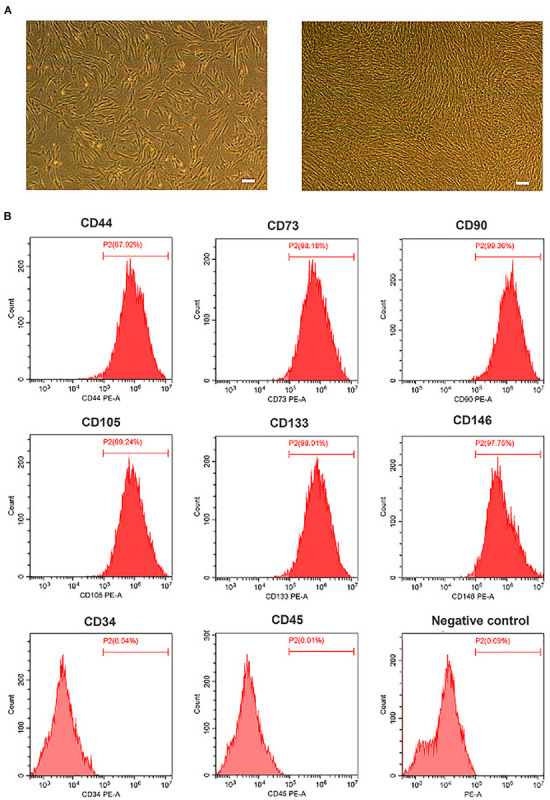
Characterization of olfactory mucosa mesenchymal stem cells (OM-MSCs). (A) Morphology of OM-MSCs in cell culture. Cultured cells [day 1 after passage (left), day 3 after passage (right)] showed typical fibroblastic or spindle morphology (scale bar, 200 μm). (B) Immunophenotype of OM-MSCs at passage 3 identified by flow cytometry analysis.